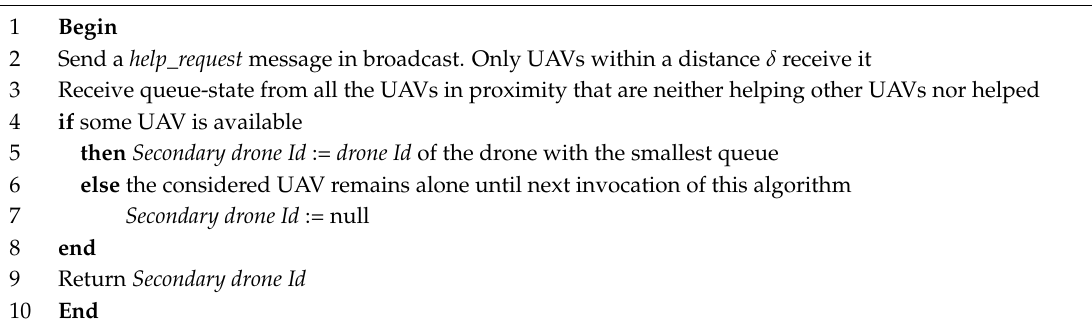
Algorithm 1. Running Search execution